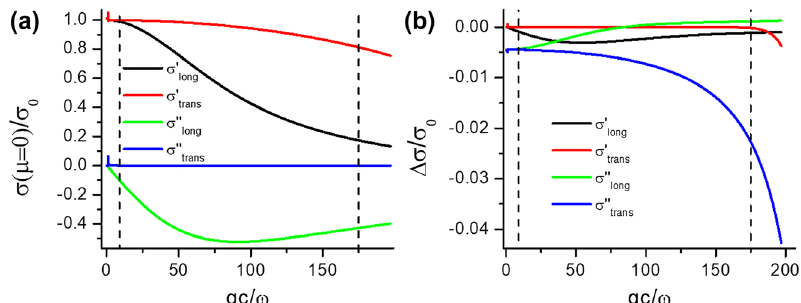
Figure 4: (a) Optical conductivities of graphene at zero bias and (b) doping depen- dence Δ 𝜎 = 𝜎 ( 𝜇 = 0 . 3 eV ) − 𝜎 ( 𝜇 = 0) as a function of wave vector, both in the propagating ( qc ∕ 𝜔 < 1) and the evanescent range ( qc ∕ 𝜔 > 1). 𝜆 = 550 nm , T = 300 K, 𝜎 = e 2 ∕ 4 ℏ . The dashed lines indicate q = 0 = 0.5 nm, marking the maximum 1 ∕ z , z 0 0 evanescent wave vectors involved in the device employed for the experiment. In (b), for 𝜎 ′ , 𝜎 ′ in the the values of Δ 𝜎 ∕ 𝜎 0 trans long propagating range are of the order of 10 − 7